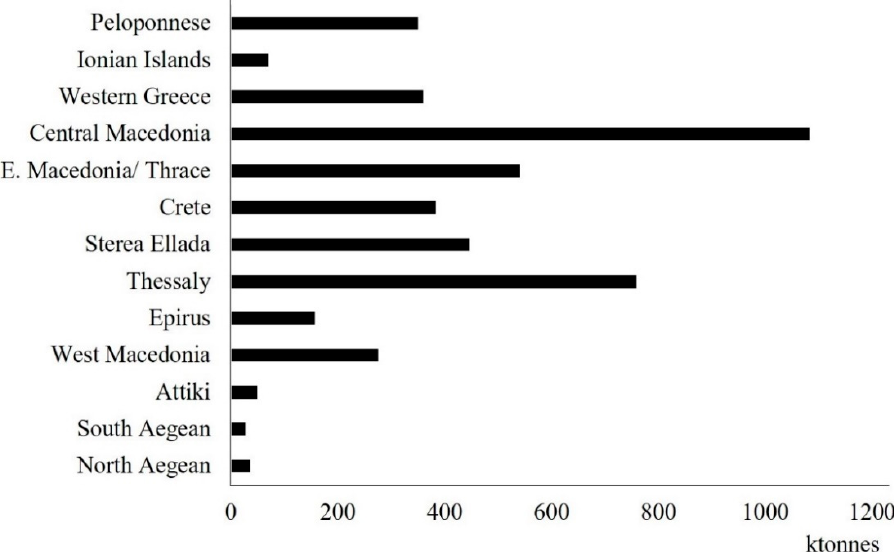
Figure 5. Potential of woody biomass in Greece by administrative region (ktonnes) [16].